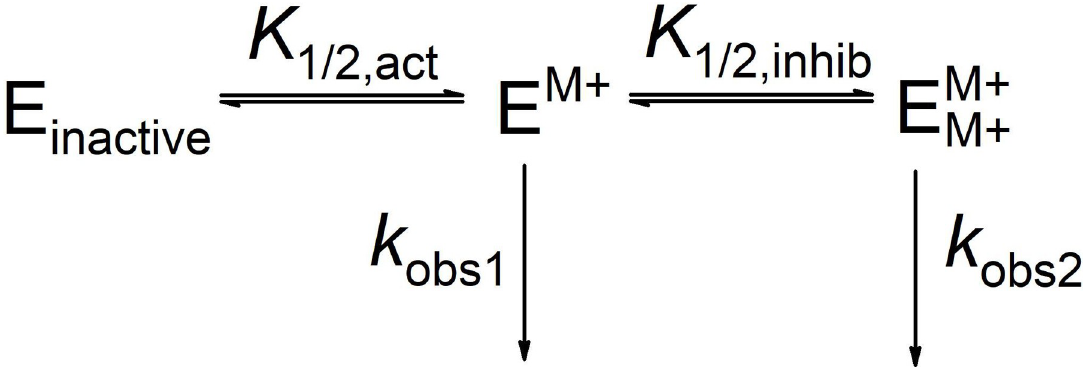
Fig 1. Binding of MVC to HDAC3:NCOR2. The binding of the first MVC activates HDAC3:NCOR2. The second MVC binding partially inhibits.